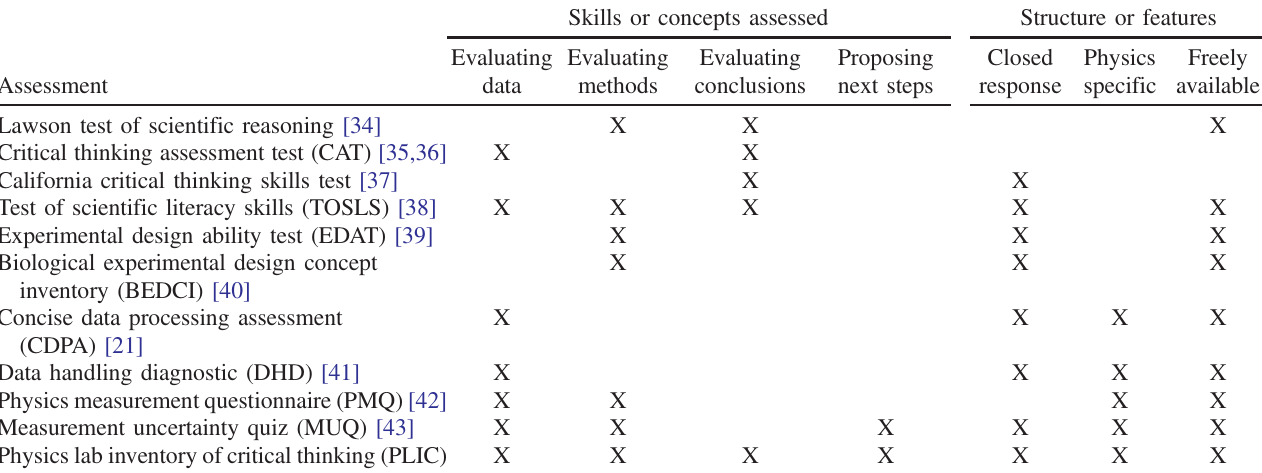
TABLE I. Summary of the target skills and assessment structure of existing instruments for evaluating lab